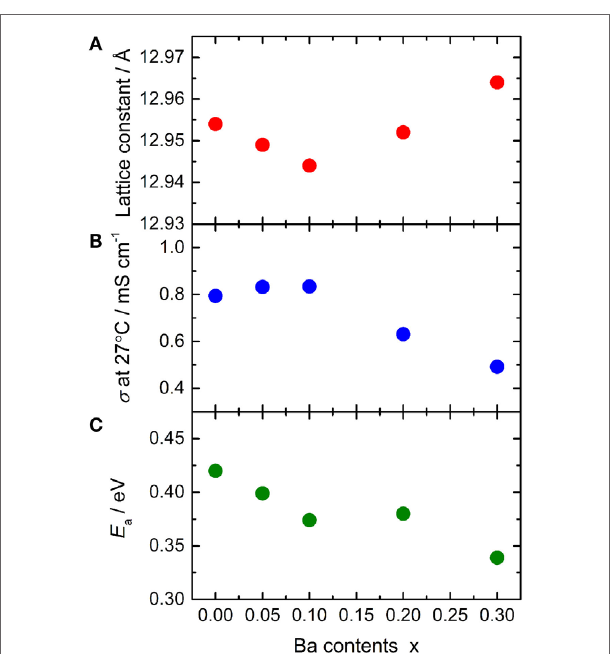
FigUre 7 | (a) lattice constant, (B) total conductivity σ at 27°c and (c) its activation energy E a for llBZT plotted against Ba contents x